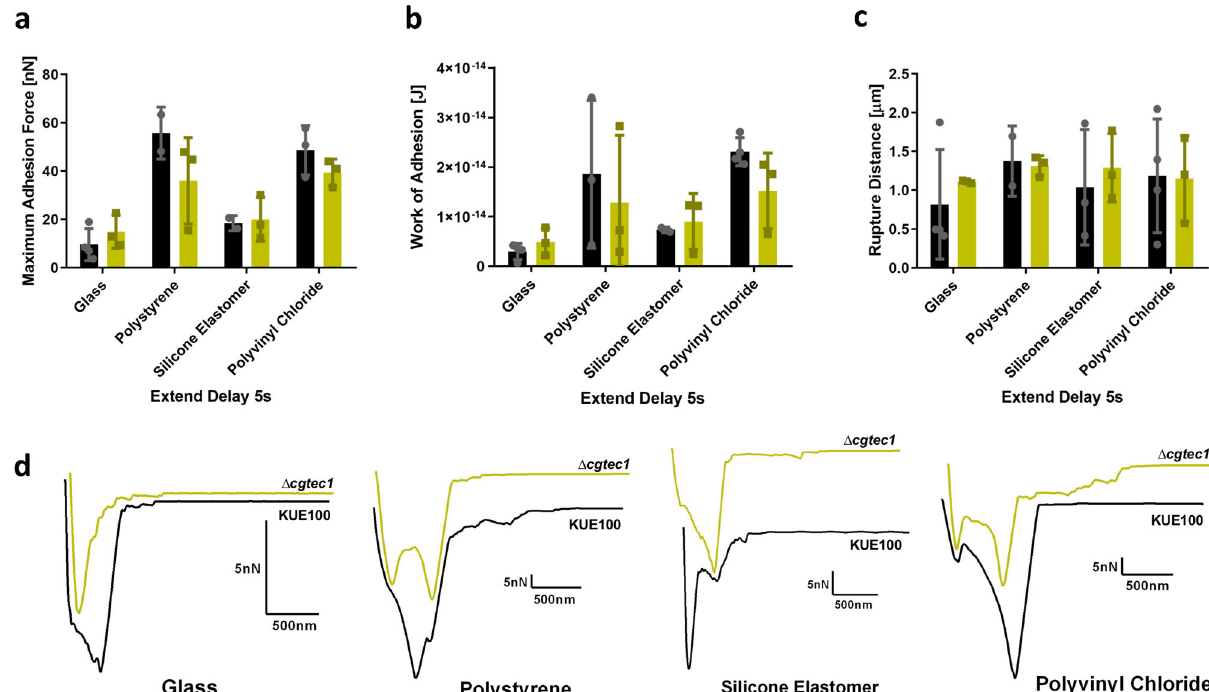
Fig. 8 CgTec1 is not necessary for C. glabrata adhesion to polystyrene, silicone elastomer, and polyvinyl chloride, with 5 s of contact time. Horizontal lines indicate the average levels of C. glabrata wild-type KUE100 strain (black) and deletion mutant Δ cgtec1 (green) regarding a maximum adhesion force, b work of adhesion, and c rupture distance measured on each retraction curve. d Representative force – distance curves of the interaction with glass, polystyrene, silicone elastomer, and polyvinyl chloride, by C. glabrata wild-type KUE100 (black) and Δ cgtec1 deletion mutant single cells (green). For every condition, at least four yeast cells, from at least three independent cell cultures, were immobilized on the cantilever for the interaction with each material. Twenty- fi ve force – distance curves were recorded per yeast cell. Error bars indicate SDs, n ≥